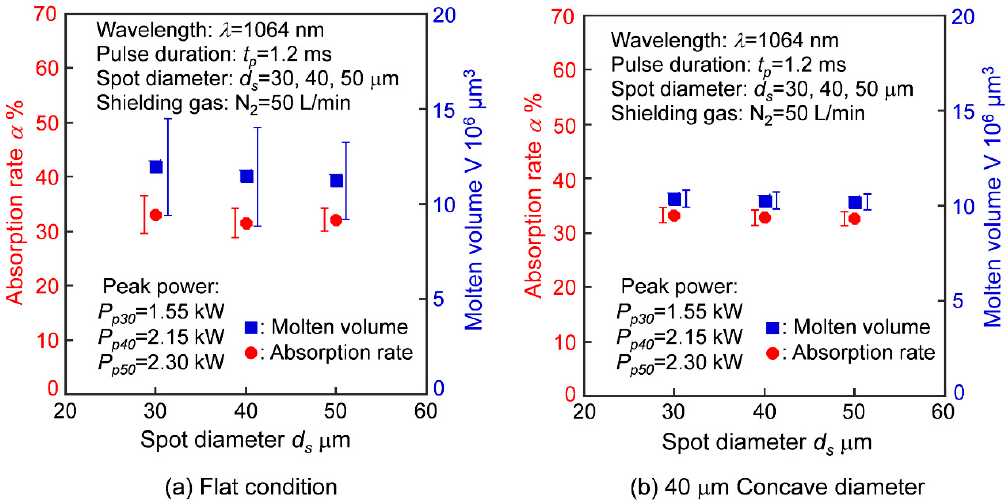
Figure 9. Variations of absorption rate and molten volume with laser spot diameters.